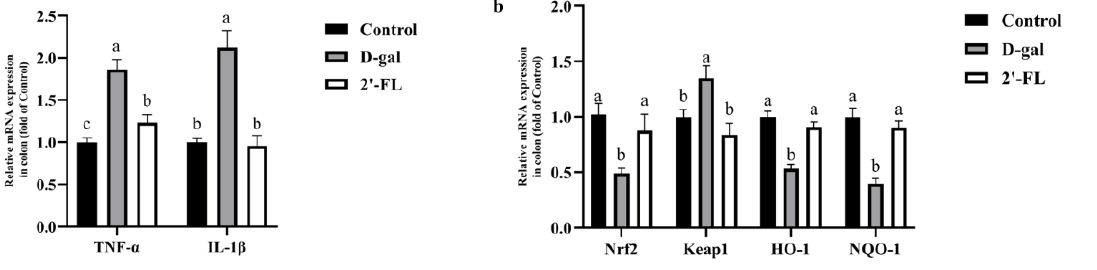
Figure 3. Effects of 2′− FL on inflammation and the nuclear factor E2 − related factor 2 (Nrf2) signaling pathway in the colon. ( a ) Expression of inflammatory cytokines at the gene level. ( b ) Expression of the Nrf2 signaling pathway at the gene level. Letters a, b, and c indicated significant differences between groups ( p < 0.05).